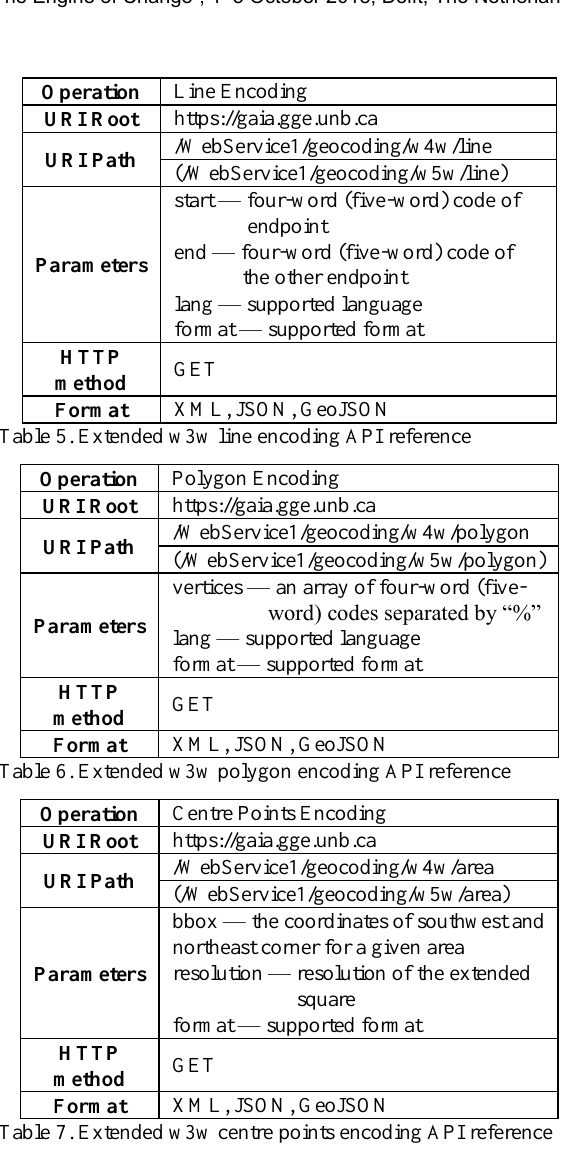
Table 7. Extended w3w centre points encoding API